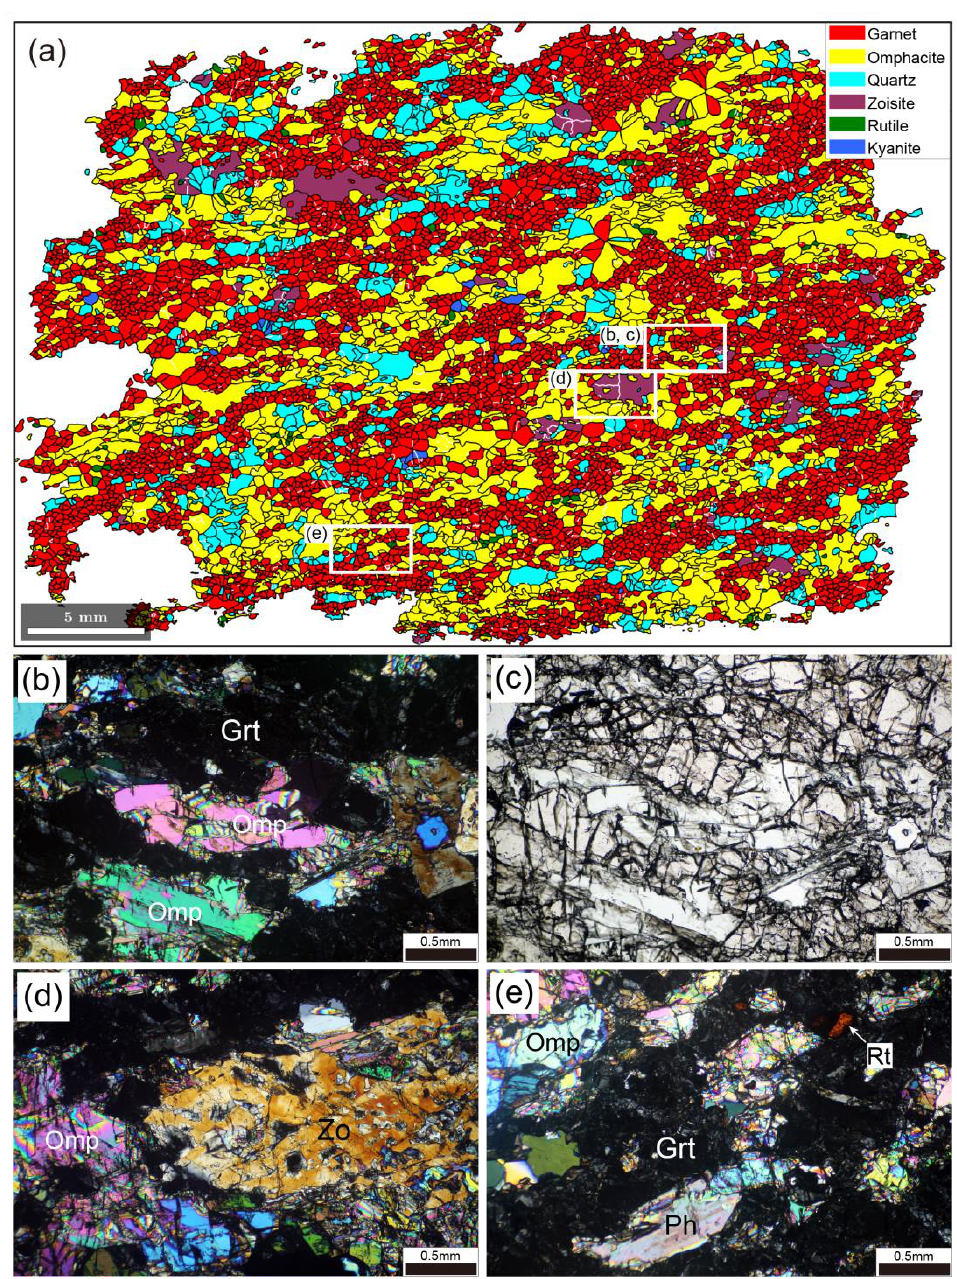
Figure 2. Microstructure of eclogite. ( a ) EBSD phase map of entire thin-section. White areas in the map are non-indexed pixels. White lines represent subgrain boundaries. White rectangles indicate areas shown in ( b – e ). ( b , d , e ) Photomicrographs under cross-polarized light. ( c ) As in ( b ), but under plane-polarized light. Grt, garnet; Omp, omphacite; Qtz, quartz; Zo, zoisite; Rt, rutile; Ph, phengite.